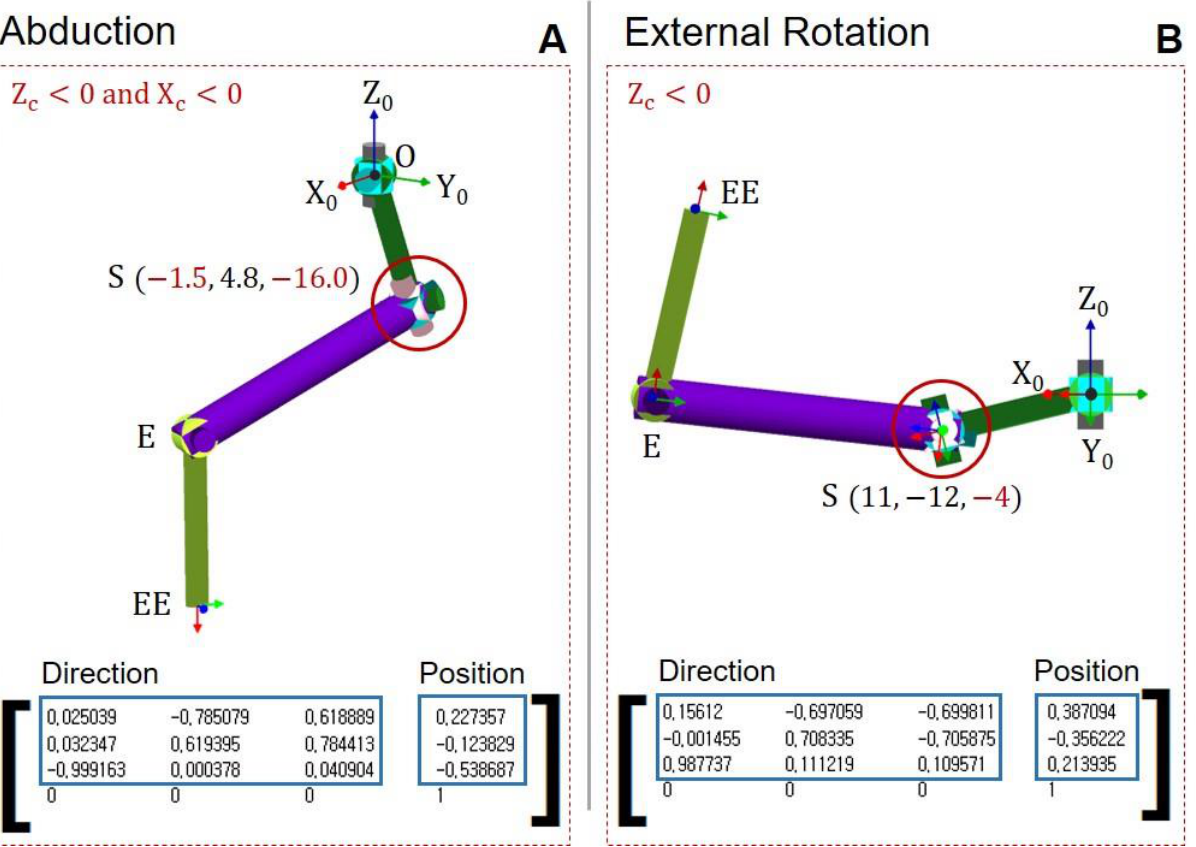
Figure 7. Simulation of shoulder movement based on the position vector of the end effector. ( A ) Math condition violation in abduction ( Z C < 0 and X C < 0 ). ( B ) Math condition violation in external rotation ( Z C < 0 ).